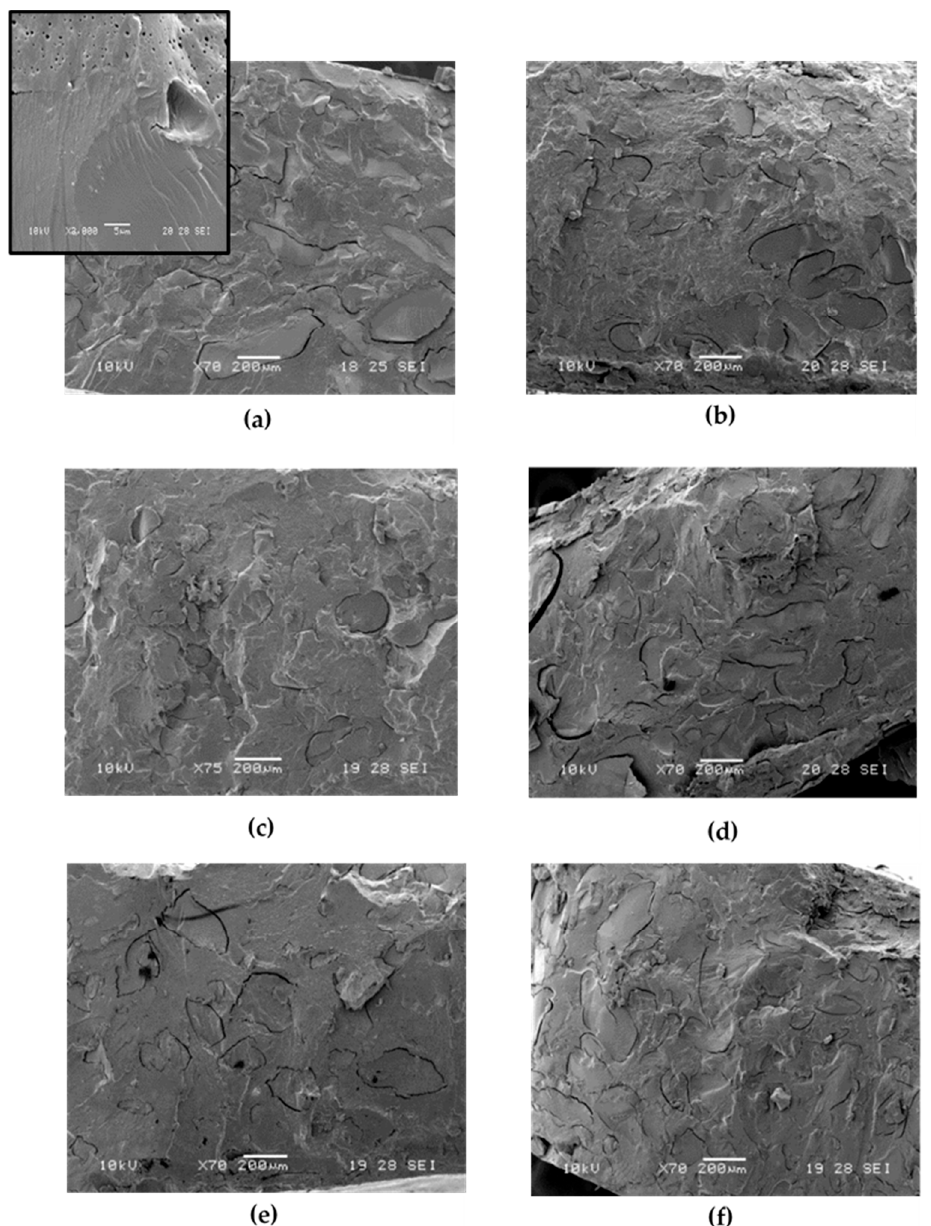
Figure 3. SEM micrographs related to PBS/PWP 60/40 with the following compatibilizers: ( a ) soy lecithin; ( b ) GMS; ( c ) OL+; ( d ) OL − ; ( e ) LA+ ( f ) LA − .